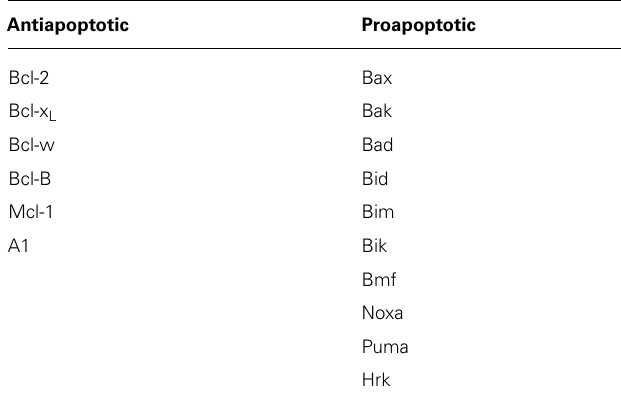
Table 3 | List of human Bcl-2